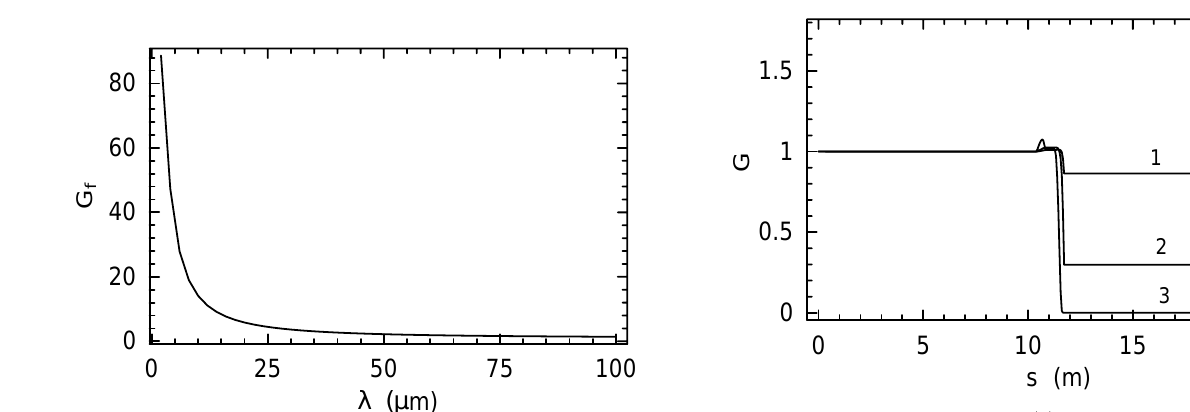
FIG. 6. Amplification factor G (cid:2) s (cid:3) for e (cid:1) 0 , s p (cid:1) 3.0 3 10 2 5 for three values of l : ( 1 ) l (cid:1) 50 m m, ( 2 ) l (cid:1) 20 m m, and ( 3 ) l (cid:1) 5 m